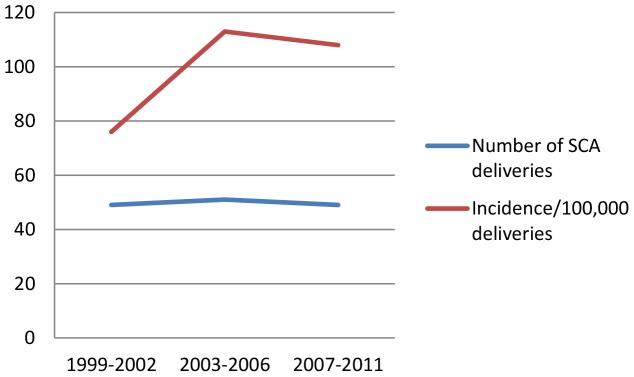
Trend of SCD deliveries at MNH.